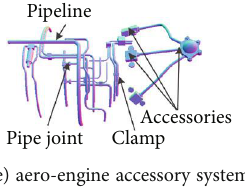
Figure 1: Various structural features of aero-engine pro fi